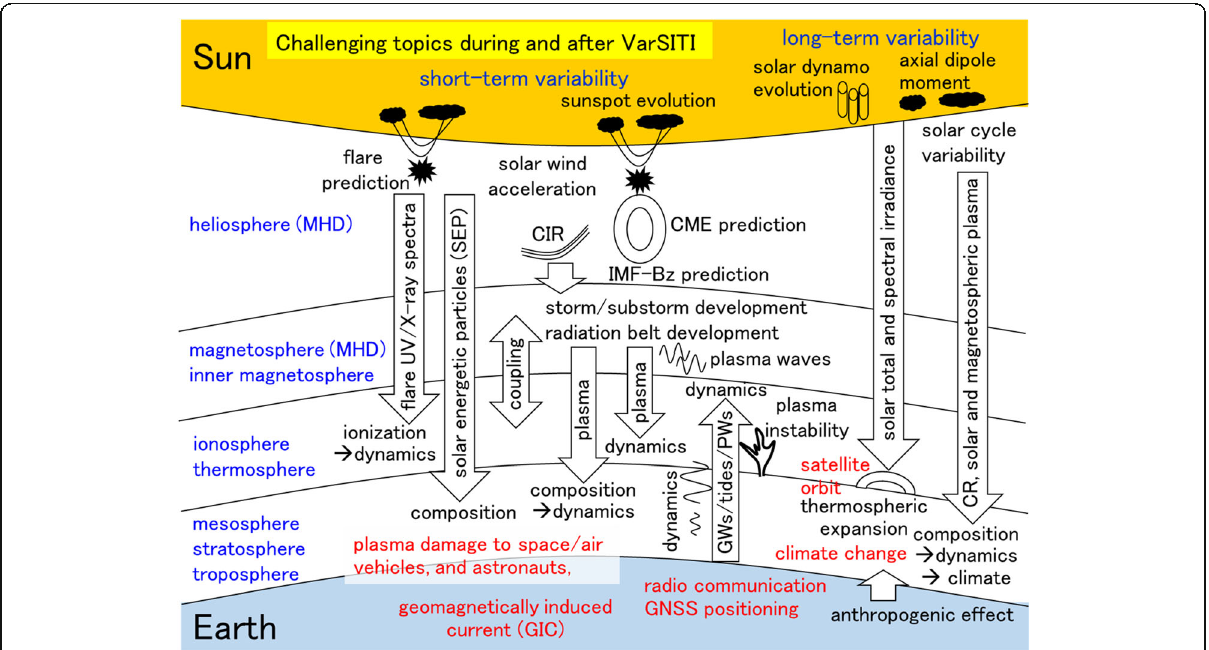
Fig. 22 Black: challenging scientific topics in the solar-terrestrial coupling during and after the VarSITI program. Red: their consequences on human life. Short and long-term variabilities are shown in the left and right side of the figure, respectively. CIR corotating interaction region, CME coronal mass ejection, CR cosmic ray, IMF interplanetary magnetic field, GNSS global navigation satellite system, GW gravity wave, MHD magnetohydrodynamics, PW planetary wave, UV